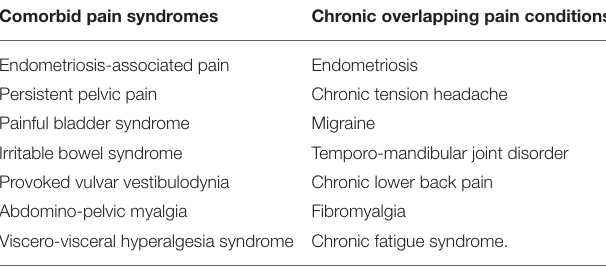
TABLE 2 | Comorbid pain syndromes vs. chronic overlapping pain conditions.